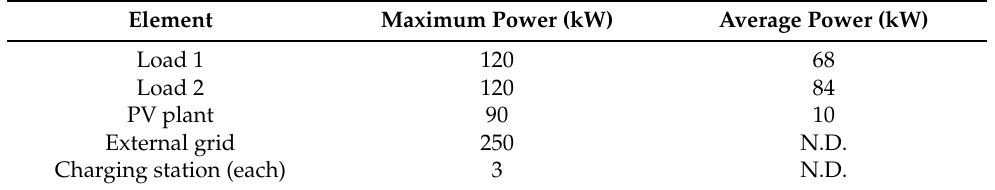
Figure 4. Sample of hourly PV plant generation profiles in the data set. Table 1 shows the main parameters of the considered micro-grid. Table 1. Microgird